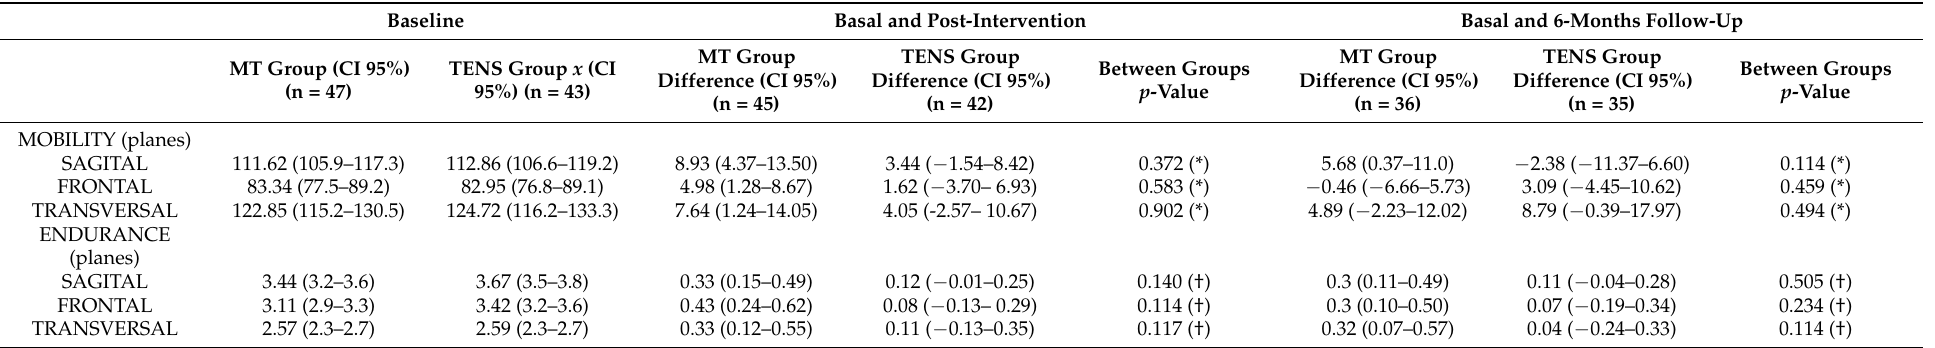
Table 3. Cervical active mobility and endurance differences before and after treatment in the different